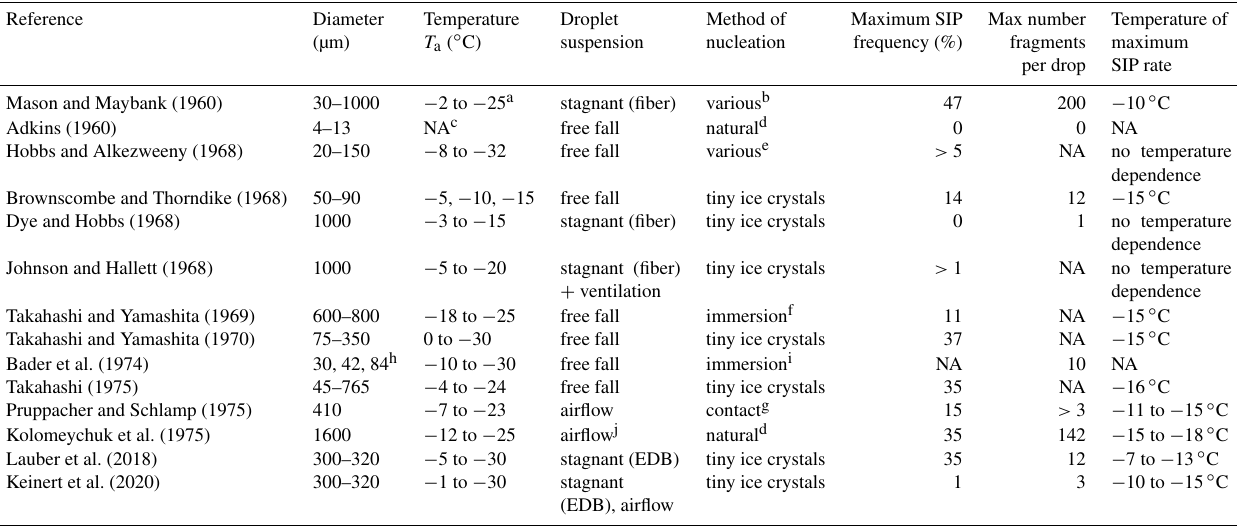
Table 1. Summary of experimental studies of droplet fragmentation during freezing by different research groups. The table covers only works that quantified the parameters included in the